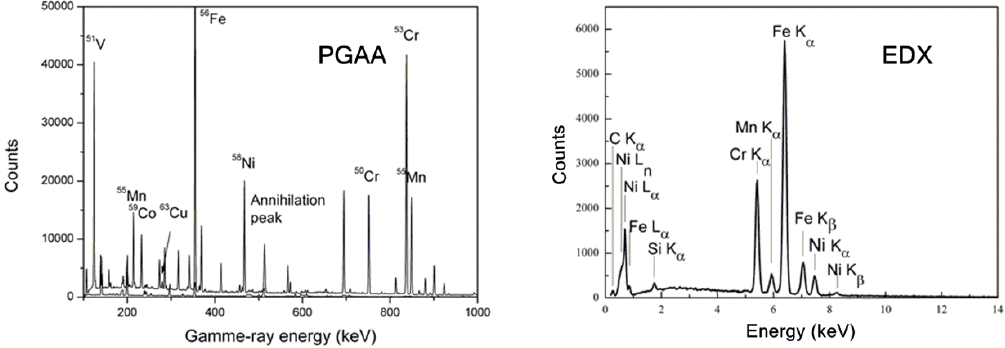
Figure 3. PGAA ( left ) and microscopy-energy dispersive X-ray spectroscopy (EDX) ( right ) spectra of G&H, with the identified peaks labelled with elemental symbols for EDX and isotopes for PGAA (measured with INES). Table 1. Quantitative elemental composition as wt-% (SD) determined by neutron PGAA 238 and EDX, for the G&H and Azdent stainless steel archwire samples.